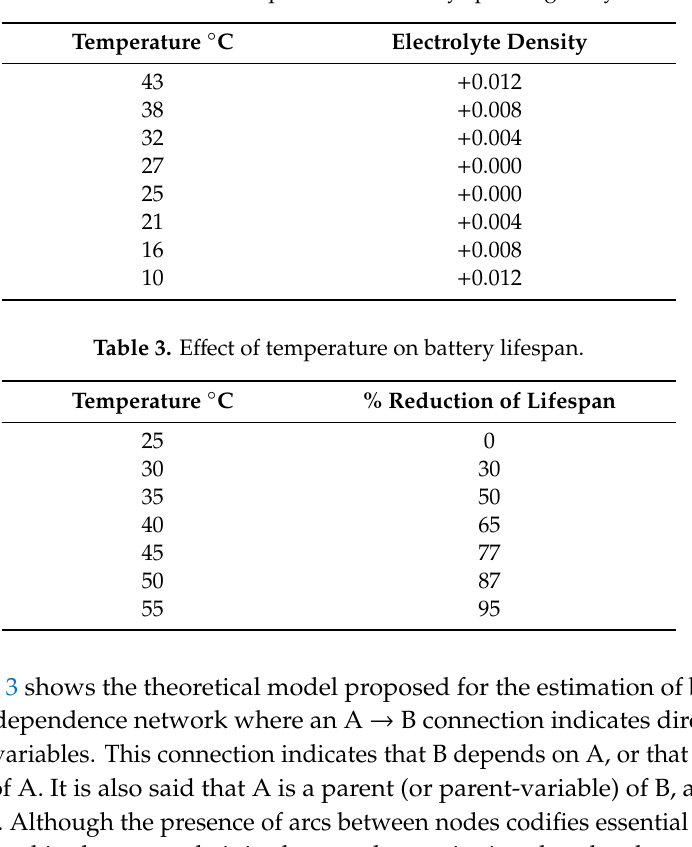
Table 2. E ff ect of temperature on battery specific gravity.